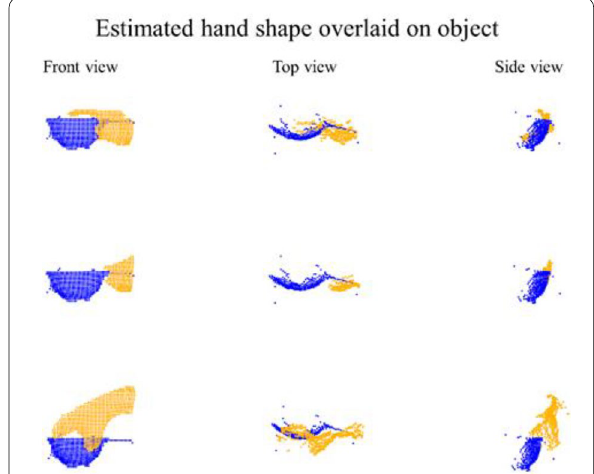
Fig. 13 Point cloud of the object and recalled grasping hand for the fourth object in Fig. 12